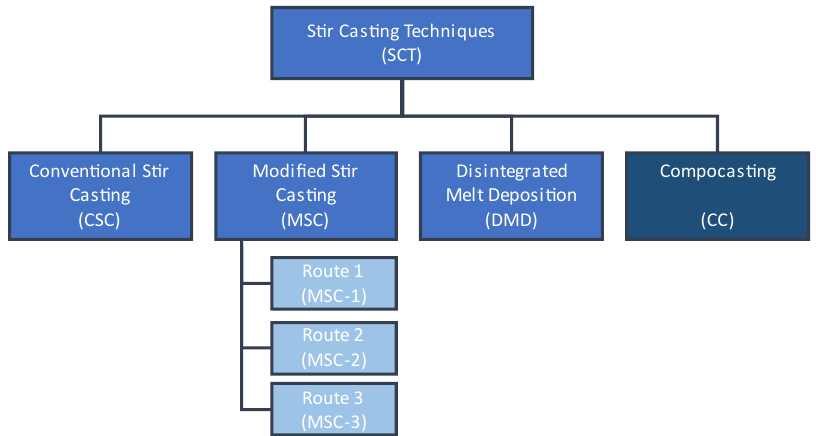
Figure 1. Classification of stir casting techniques (SCTs) for processing MMSFs.